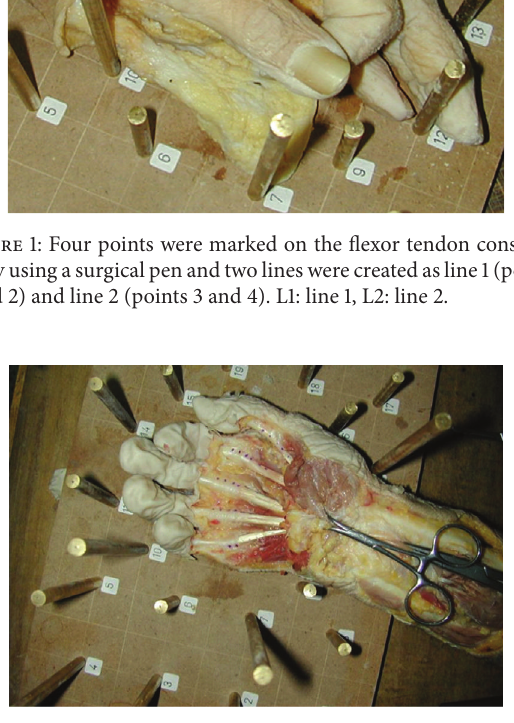
Figure 2: The photogrammetric evaluation was performed using 8– 10 control points and 6 tie